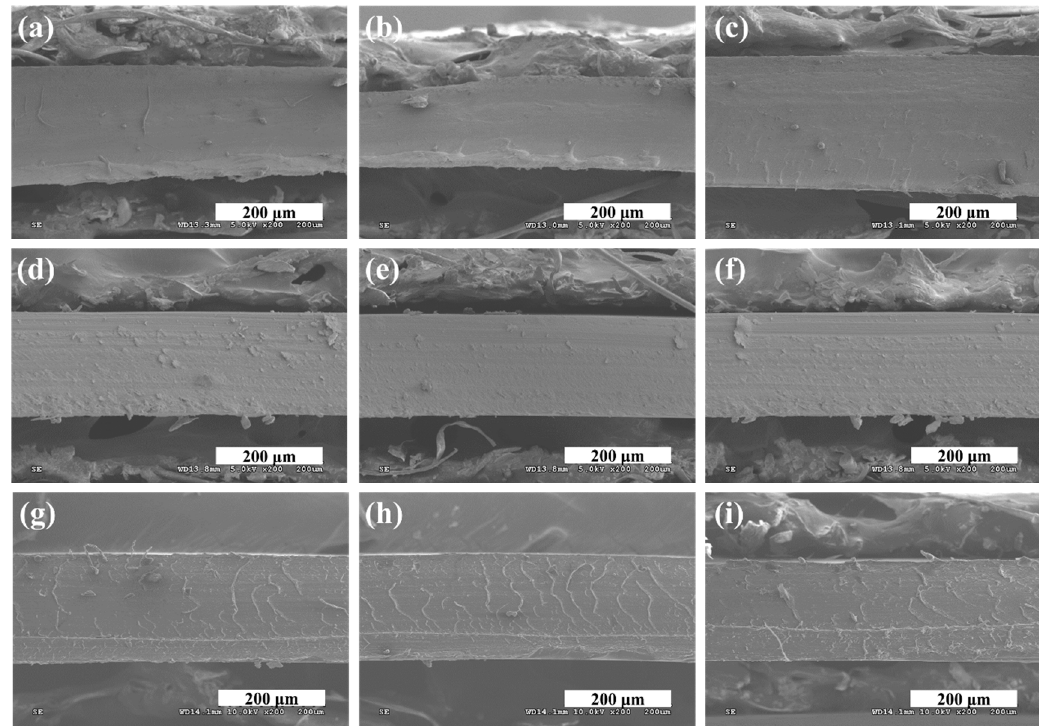
Figure 3. Cross-sectional SEM images of ( a – c ) evaporation-fabricated Nafion membrane without multiwalled carbon nanotubes (MWCNT), ( d – f ) HPTS-fabricated Nafion membrane without MWCNT, and ( g – i ) HPTS-fabricated Nafion and 1.0 wt% MWCNT composite membrane.